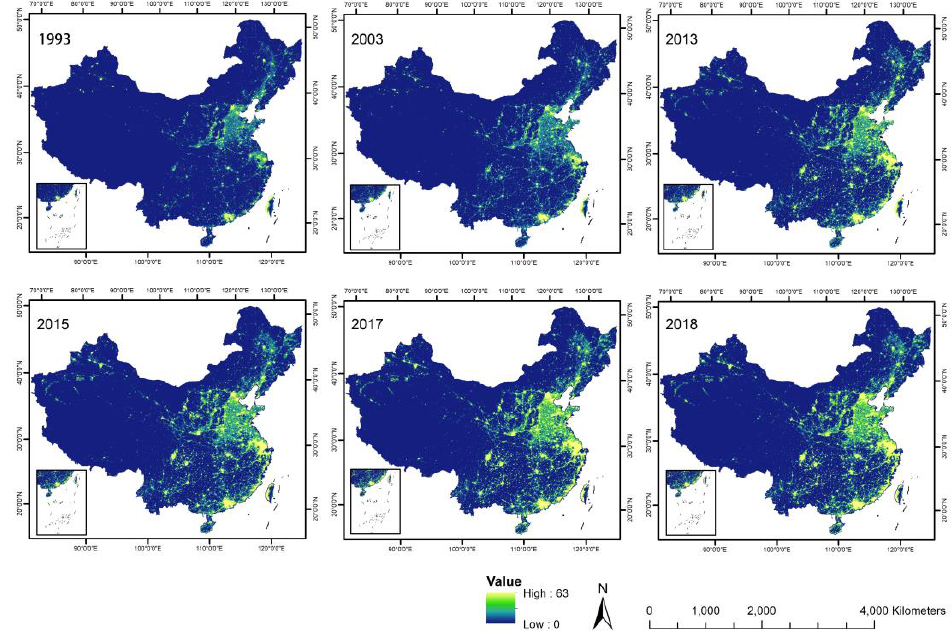
Figure 7. NTL images of China in some of years.